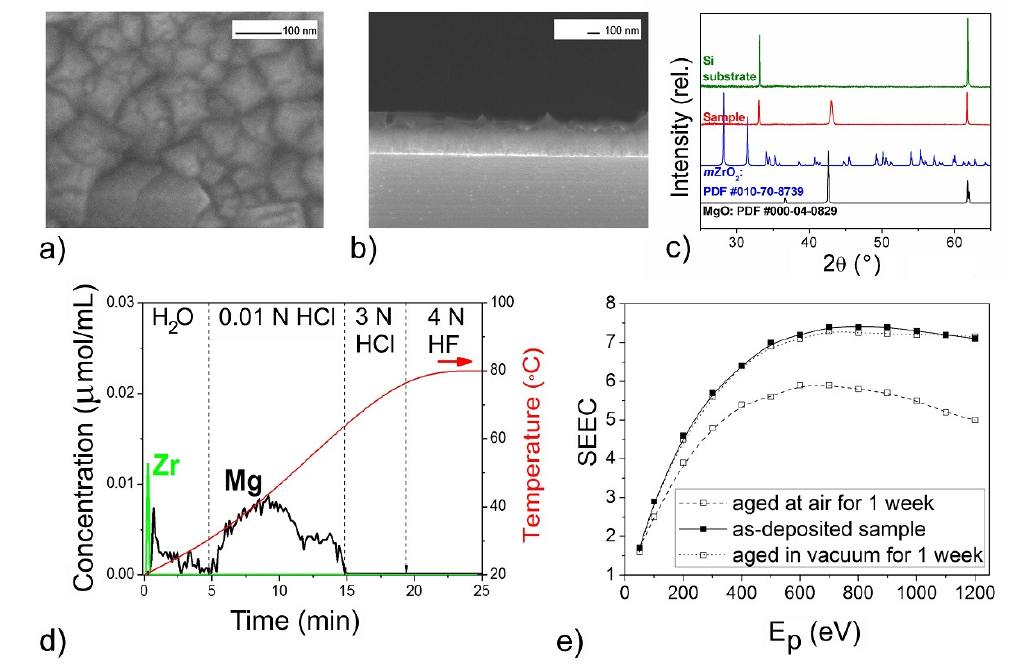
Figure 3. The mixed oxide film with n(Mg):n(Zr) = 50 according to DD data: SEM images ( a , b ), XRD pattern ( c ), DD curves ( d ), SEEC-E p curves ( e ).